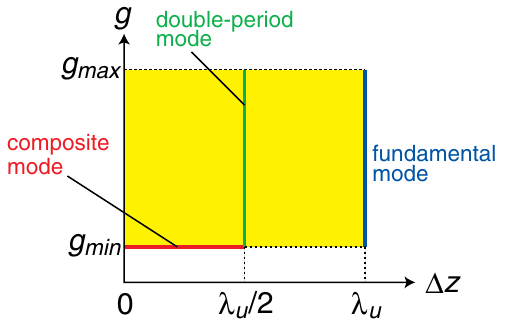
FIG. 3. Operation modes of the CPU. The magnet gap g and shift (cid:1) z are assumed to be varied from g min and 0 to g max and (cid:1) respectively. The region painted yellow indicates the possible combination of g and (cid:1) z , while the three line segments show the operation modes of practical